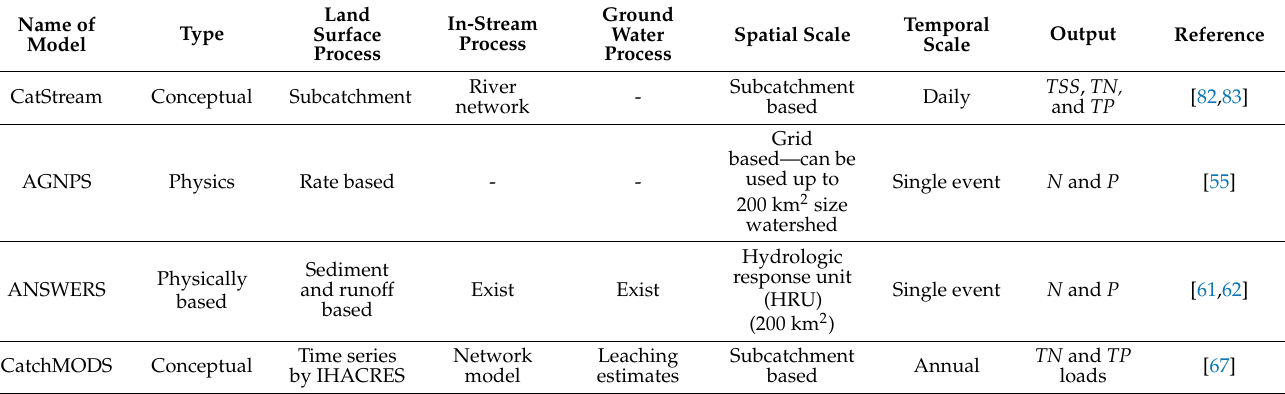
Table A3. The summary of integrated basin-scale